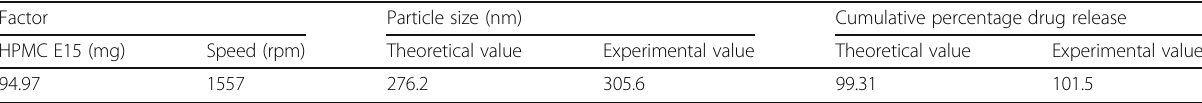
Table 9 Comparison of theoretical values and experimental values on particle size and cumulative percentage drug release